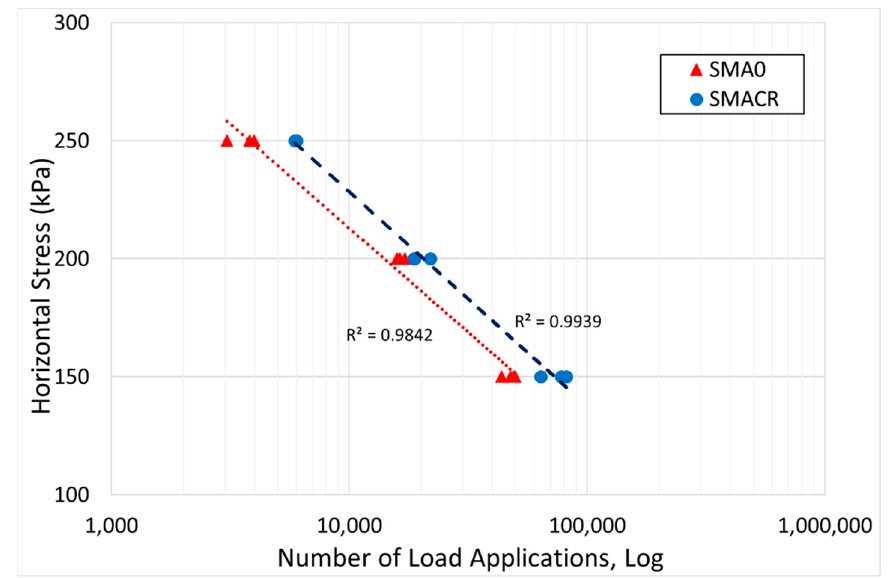
Figure 13. Mastics time sweep test comparison.